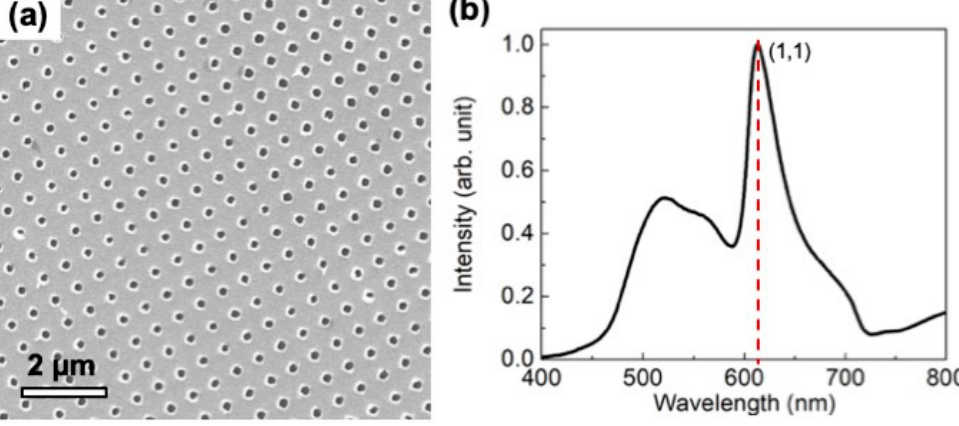
Figure 1. ( a ) SEM image and ( b ) transmission spectra of a gold nanohole array fabricated by interference lithography (IL) with a period of ʌ = 500 nm. The plasmonic peak of resonance order (1,1) presents a maximum at 615 nm.